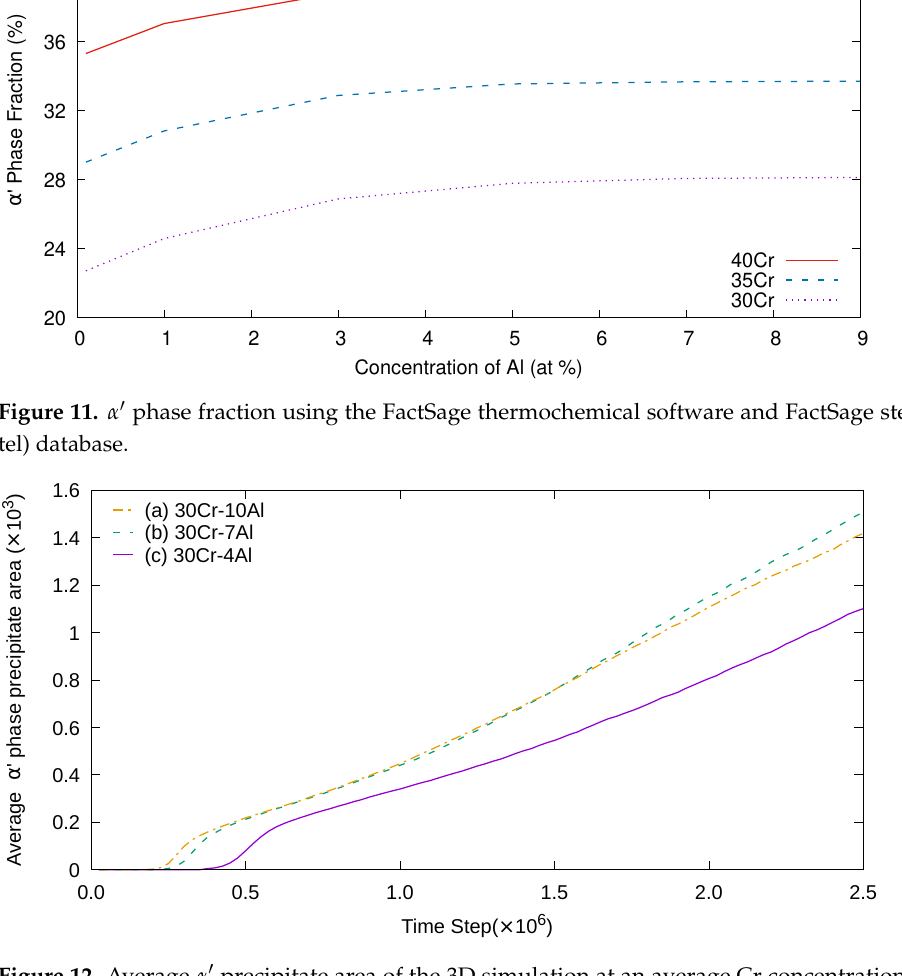
Figure 12. Average α (cid:48) precipitate area of the 3D simulation at an average Cr concentration of 30% when the average Al concentration was ( a ) 10%, ( b ) 7%, and ( c ) 4%.